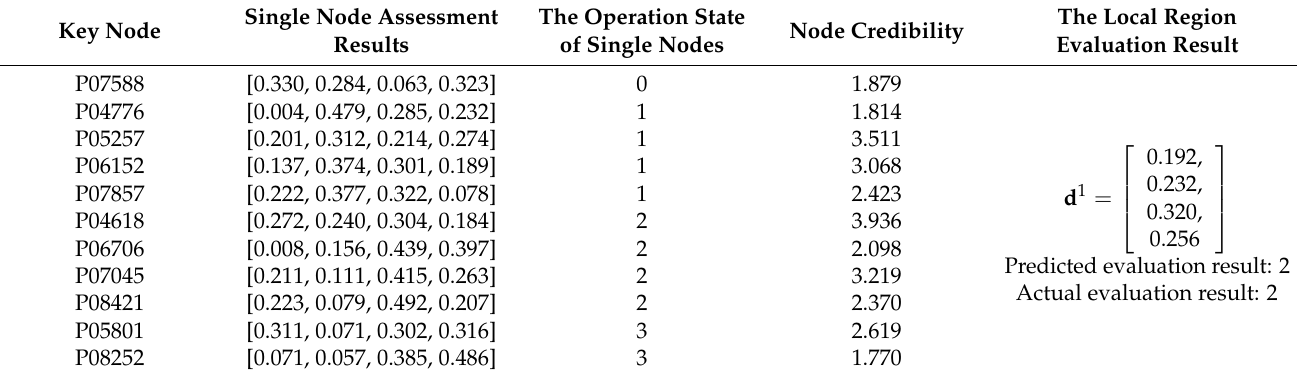
Table 2. Single region evaluation instance on September 12, 2017.